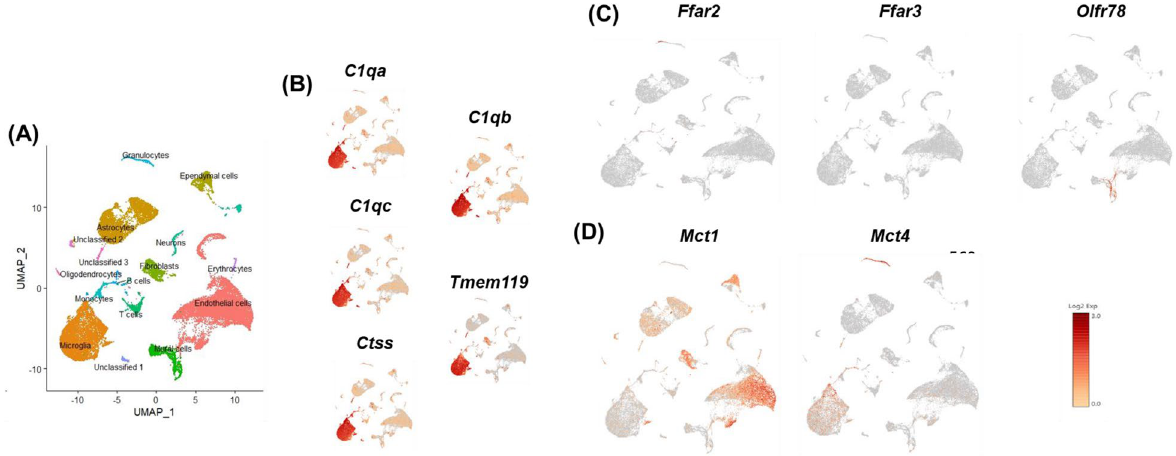
Figure 6. Uniform Manifold Approximation and Projection (UMAP) visualization of cell clusters identified during scRNA-seq analysis of mouse whole brain tissue and SCFA receptors and transporters expression. (Panel A ) identifies each cell type by name and color. (Panel B ) illustrates the expression of microglia markers ( C1qa, C1qb, C1qc, Ctss , and Tmem 119 ) used to identify microglial cells. (Panels C and D ) illustrate the expression of SCFA receptors, Ffar2, Ffar3 , and Olfr78 , and transporters, Mct1 (Slc16a1) and Mct4 (Slc16a3 ), respectively. Microglia lack the expression of all receptors but express both transporters.